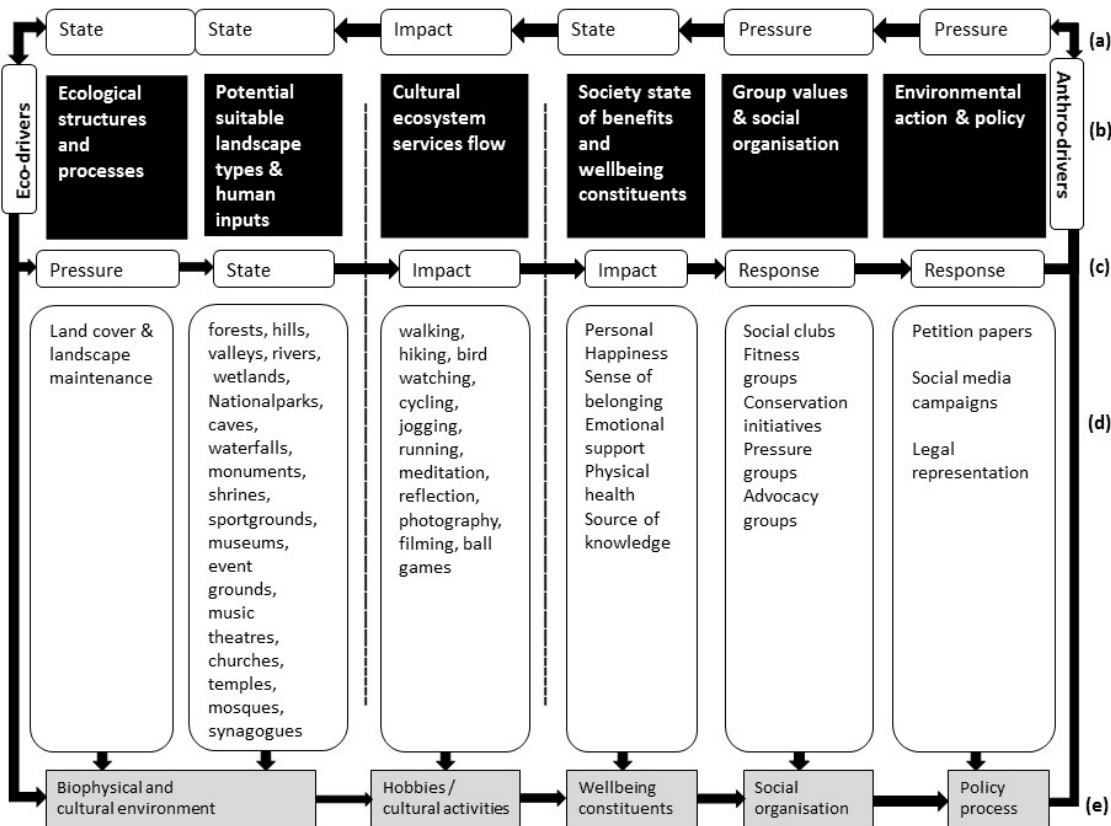
Figure 5: Connectivity between cultural ecosystem services (tourism and recreation) and wellbeing and integrating the connectivity to the ‘ES cascade’ and the DPSIR model (n=24). Part (a) is the right-left flow DPSIR model; (b) the extended ES cascade based on ecosystem theories to accommodate human wellbeing, which is based on social theories; (c) left-right flow DPSIR model; (d) practical definitions of part (b) using literature and case study data; (e) composite terminology for transparently communicating content of part